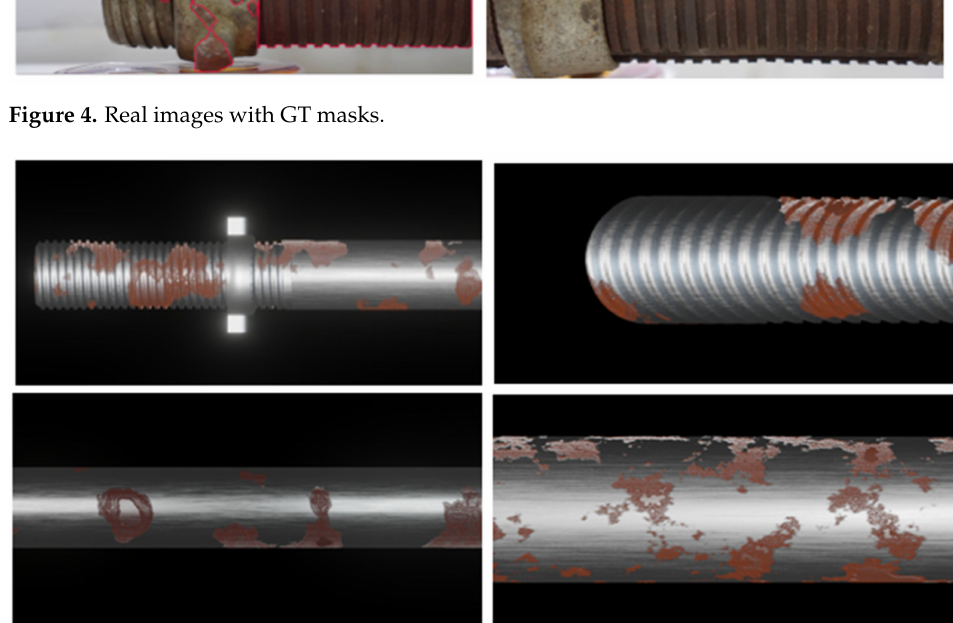
Figure 5. Synthetic images.